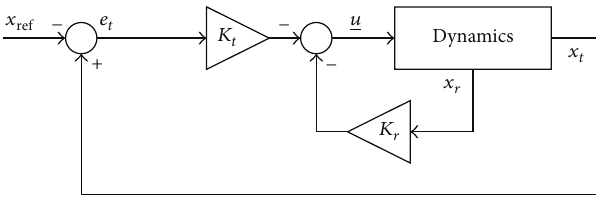
Figure 9: Structure of the LQ